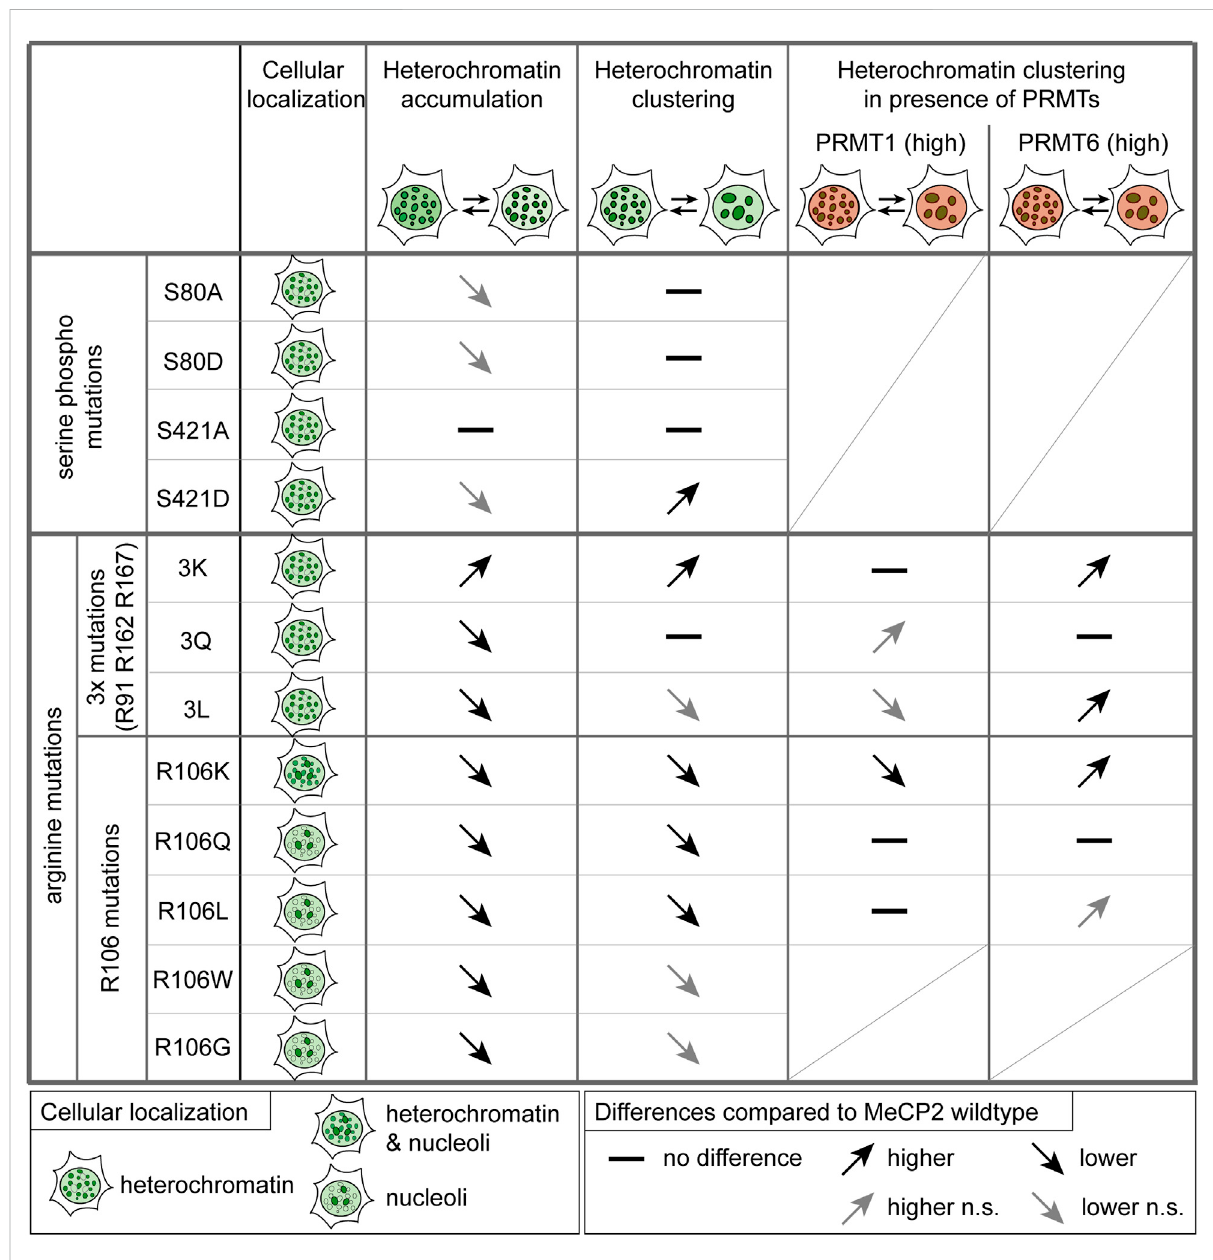
FIGURE 8 Summary of the functional characterization of MeCP2-induced heterochromatin organization. Functional differences of the MeCP2 PTM mutants in comparison to the wild type protein are represented as arrows showing increase (pointing up) and decrease (pointing down), if not statistically signi fi cant (n.s.) in gray, and no difference is marked by a line. Triple mutations stands for R91/R162/R167 mutations. Heterochromatin accumulation and clustering are MeCP2 dose-dependent. For the heterochromatin clustering in presence of PRMT1 and 6, only high PRMT levels were considered.